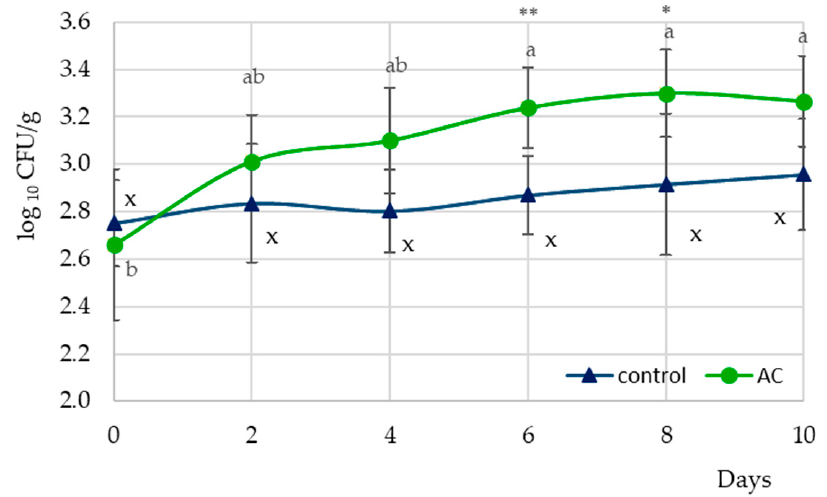
Figure 1. Changes in L. monocytogenes counts (log 10 CFU/g) in control and alternatively cured (AC) sausages during storage. Vertical bars refer to standard deviation; a,b values noted in AC products with different letters differ at p < 0.05; x —values noted in control products with the same letter did not differ ( p > 0.05); ** differences between control and AC significant at p < 0.01; * differences between control and AC significant at p < 0.05.